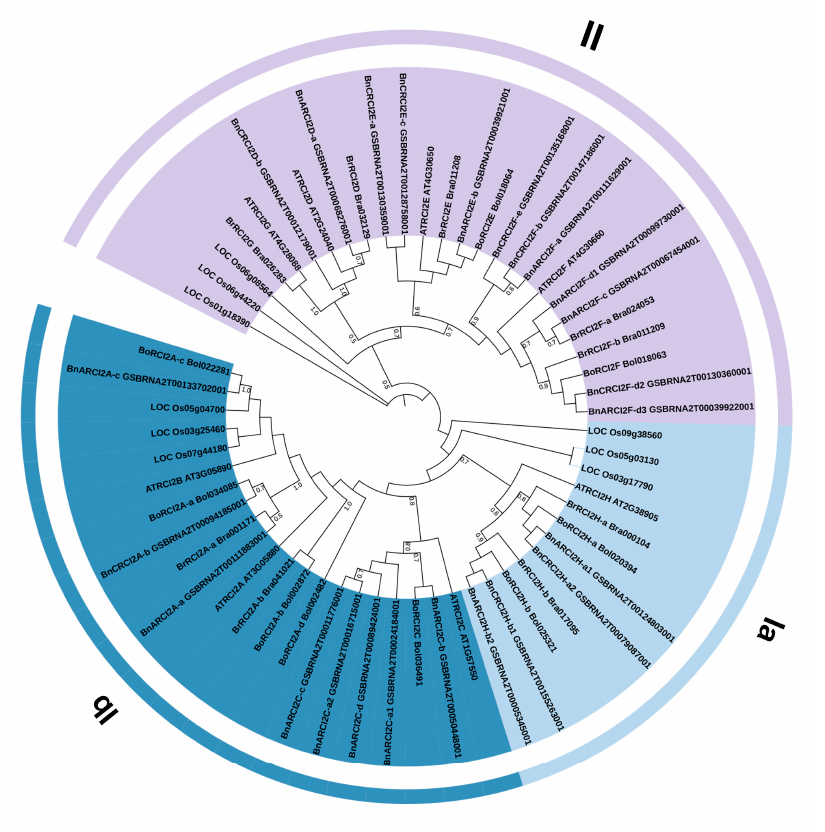
Figure 1. Phylogenetic tree of RCI2 gene family in B. rapa , B. oleracea , and B. napus , Arabidopsis and Oryza sativa , including 59 RCI2 proteins, was divided into two groups (I and II) and further divided into three subgroups (Ia, Ib and II). A bootstrap value greater than 50% was displayed at the base of the branch.